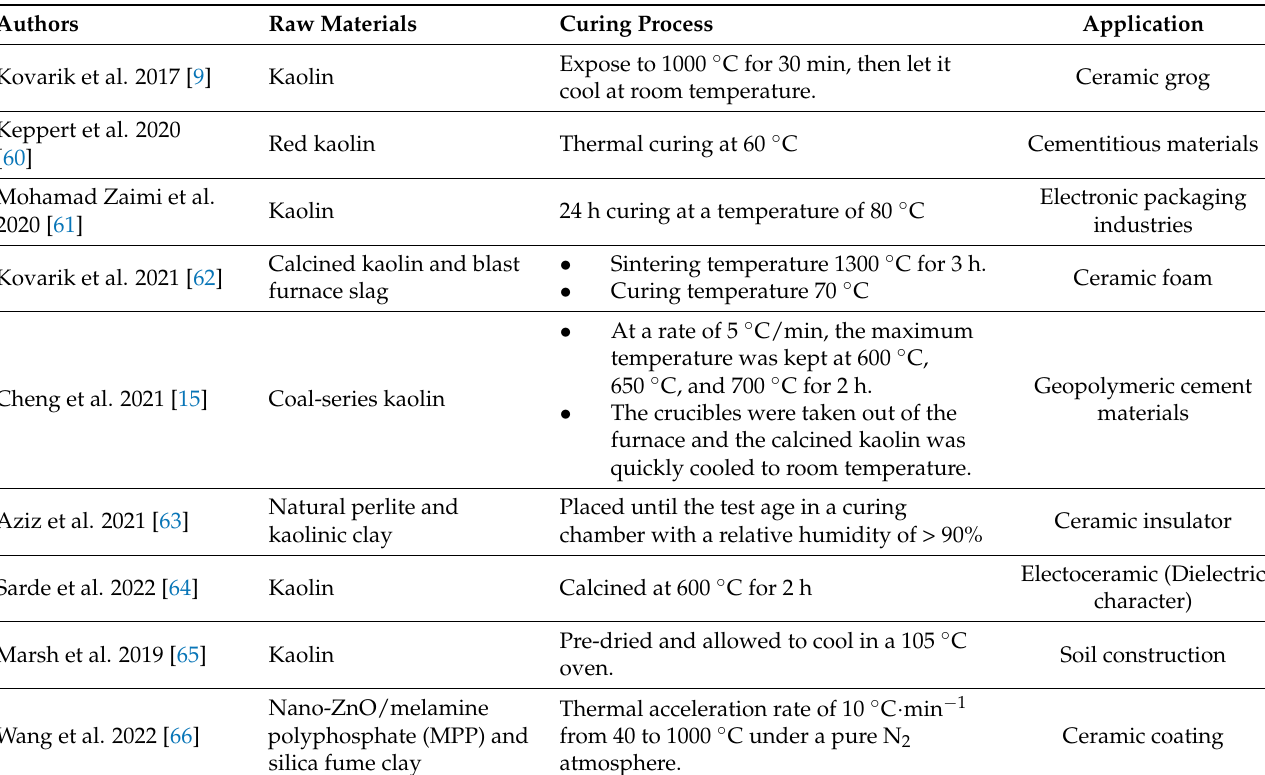
Table 2. Kaolin geopolymer on various ceramic